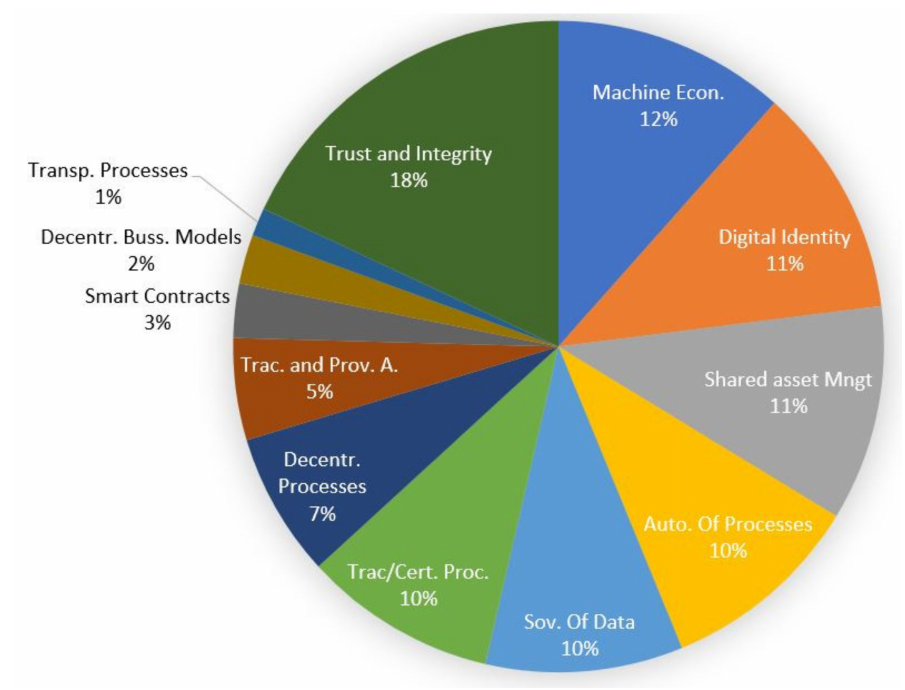
Figure 3. Blockchain investment distribution by business